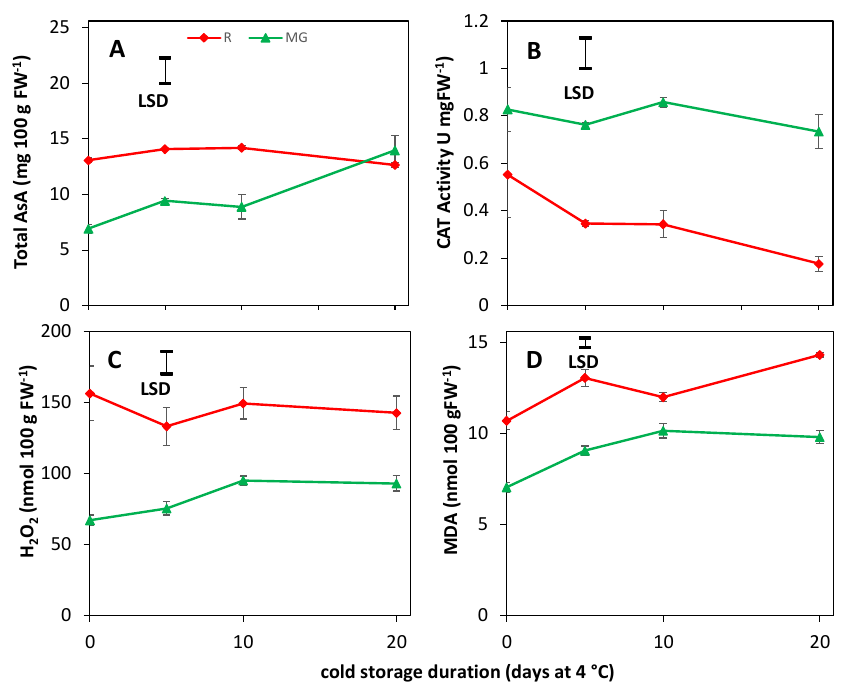
Figure 5. Changes in total AsA ( A ), CAT activity ( B ), H 2 O 2 ( C ), and MDA ( D ) content at harvest and cold storage (4 °C) for fifteen MG (green symbols) and fifteen R tomatoes (red symbols). Light treatment effects were not significant and therefore values are shown only per maturity. LSD values are indicated per panel.